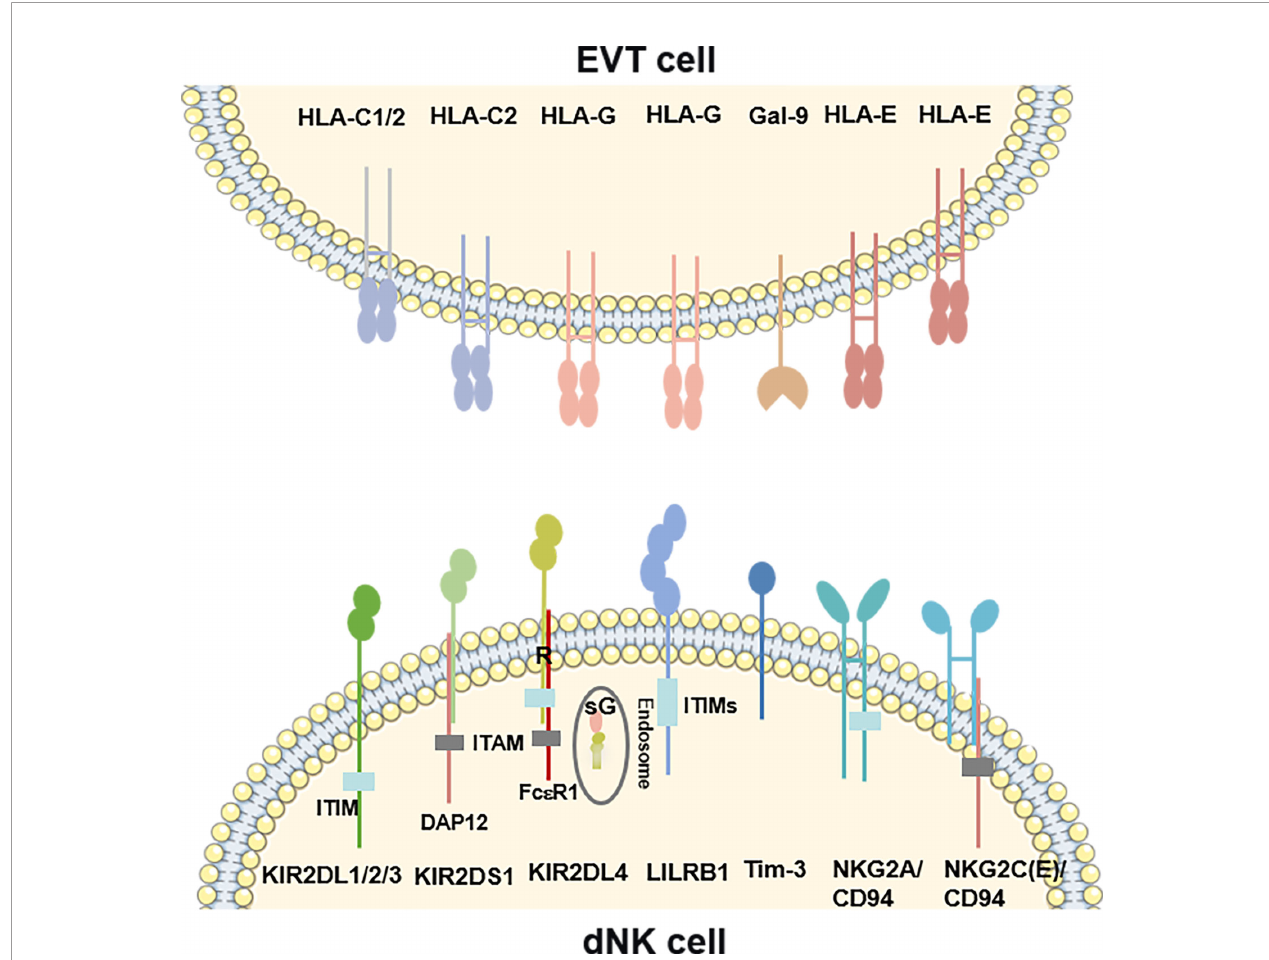
FIGURE 1 | Overview of the ligand-receptor pairs between dNK cells and EVT cells. KIR2DL1, 2DL2 and 2DL3 are inhibitory receptors containing ITIMs, which bind with HLA-C on EVT cells. KIR2DS1 also interacts with HLA-C on EVT cells and activates downstream by combining with an ITAM – bearing adaptor DAP12. KIR2DL4, recognizing the HLA-G on EVT cells or sG from EVT cells, exhibits structural characteristics of both activating and inhibitory KIR by possessing a transmembrane R residue and a cytoplasmic ITIM. The transmembrane R binds with the adaptor protein Fc ϵ R1 to transduce activating signals. KIR2DL4 is located in endosomes, and transferred to the surface of dNK cells when cultured with IL-2 in vitro . LILRB1 is also the HLA-G receptors containing four ITIMs in their cytoplasmic domains. NKG2 members form a heterodimer with CD94 and recognize HLA-E. NKG2A/CD94 is an inhibitory receptor owning ITIM in their cytoplasmic. While, NKG2C/E is activating receptors associated with the DAP12. Tim-3 interacts with its ligand Gal-9 on EVT cells. R, arginine; sG, soluble HLA-G; DAP12, DNAX-activating protein of 12; ITAM, Immunoreceptor tyrosine-based activation motif. ITIM, Immunoreceptor tyrosine-based inhibitory